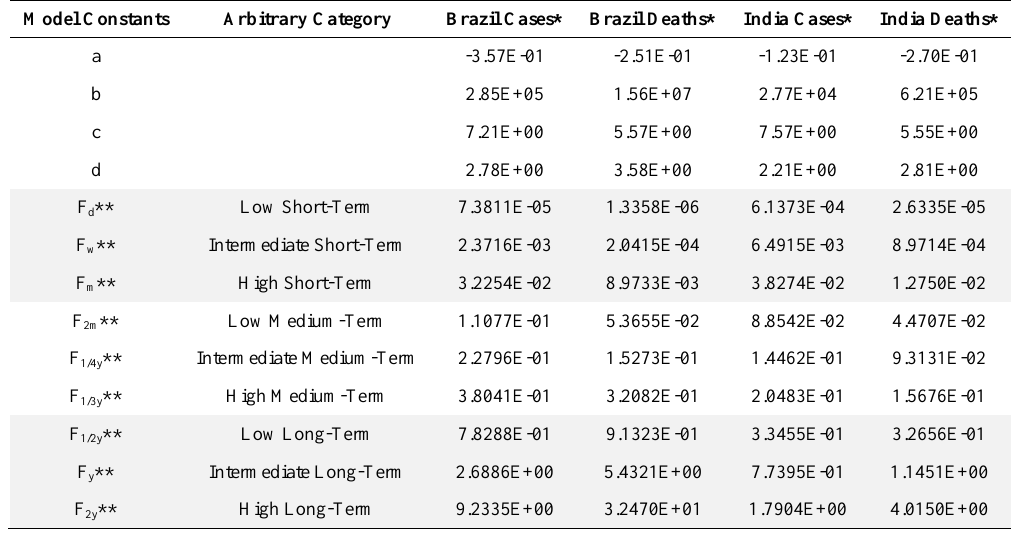
Table 3. Differential time-risk Factor (F) of the cumulative morbidity and mortality rates for two examined distinct political regions following MMF dataset